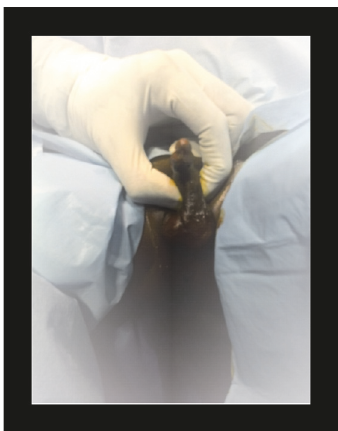
Figure 1: Palpation of mass at the base of the penis (case 1).